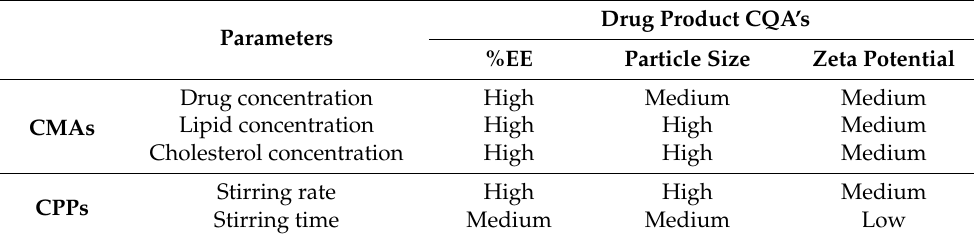
Table 2. Risk estimation